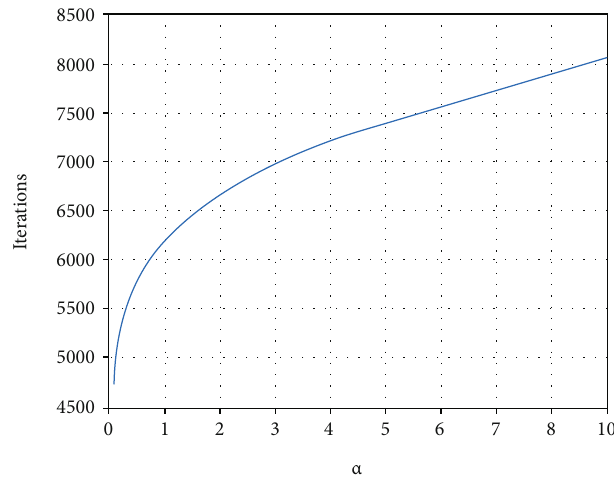
Figure 3: Alpha vs. iterations, for small alpha.